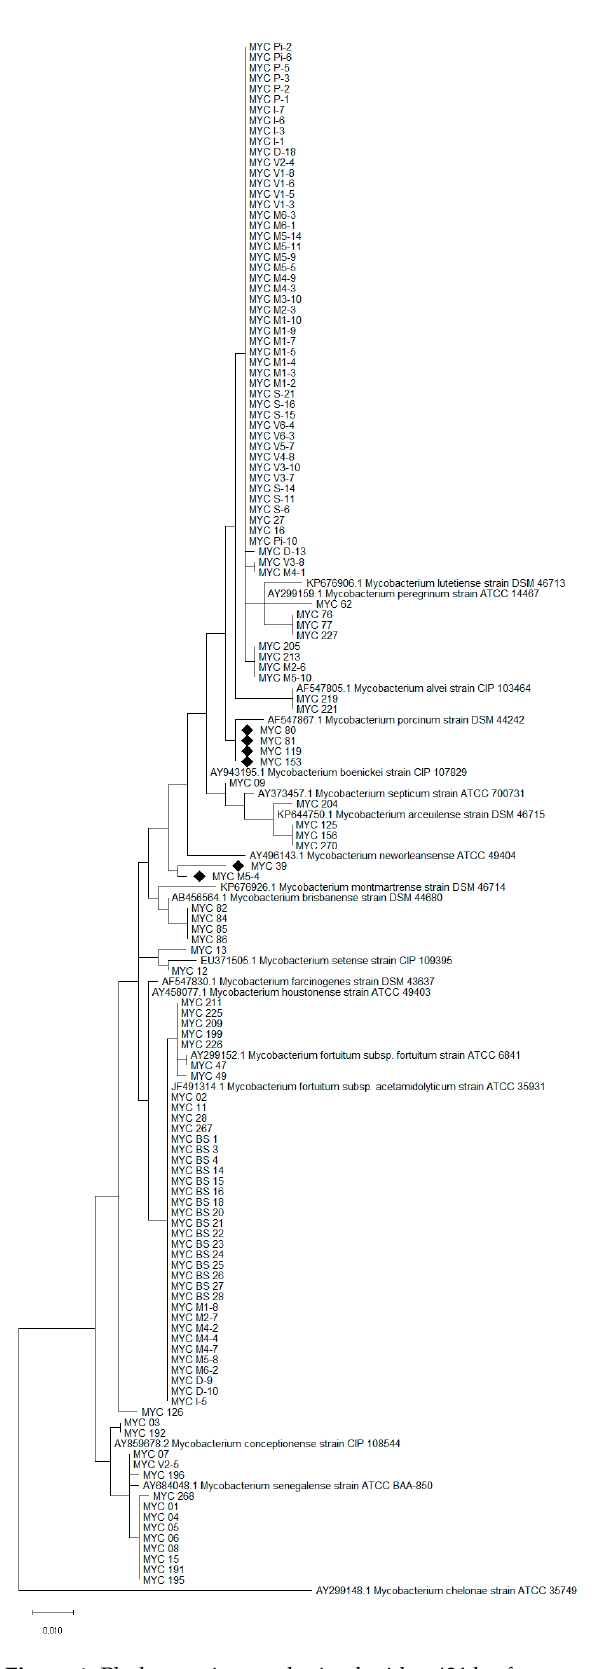
Figure 1. Phylogenetic tree obtained with a 421 bp fragment of the hsp65 gene. The strains indicated with the symbol “ (cid:7) ” gave conflicting results between gene sequencing and phylogenetic